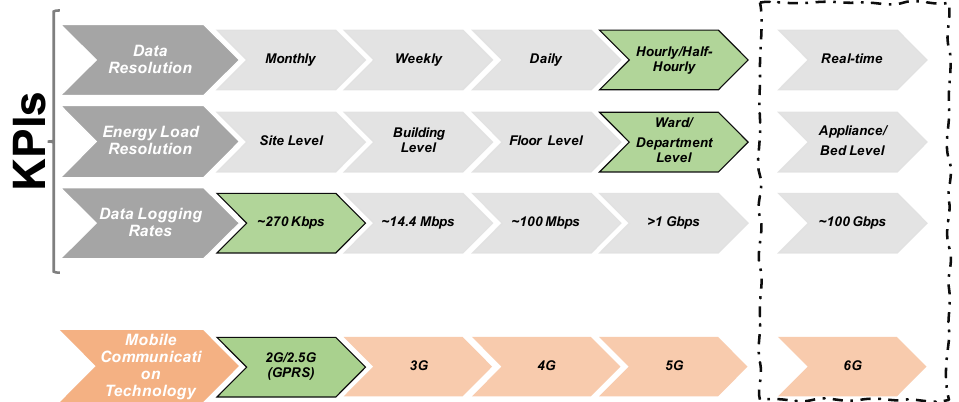
Figure 12. Evolution and evaluation of smart utility monitoring technology in the context of mobile generations